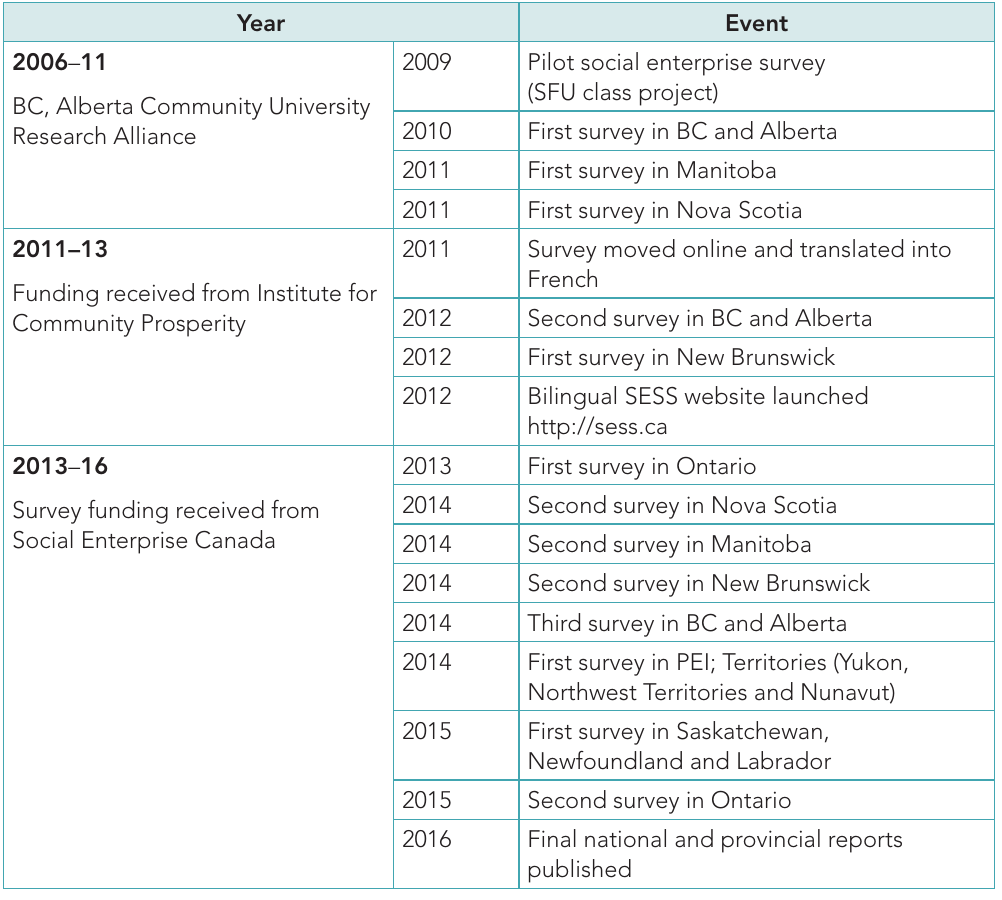
Table 2: Social enterprise sector survey evolution